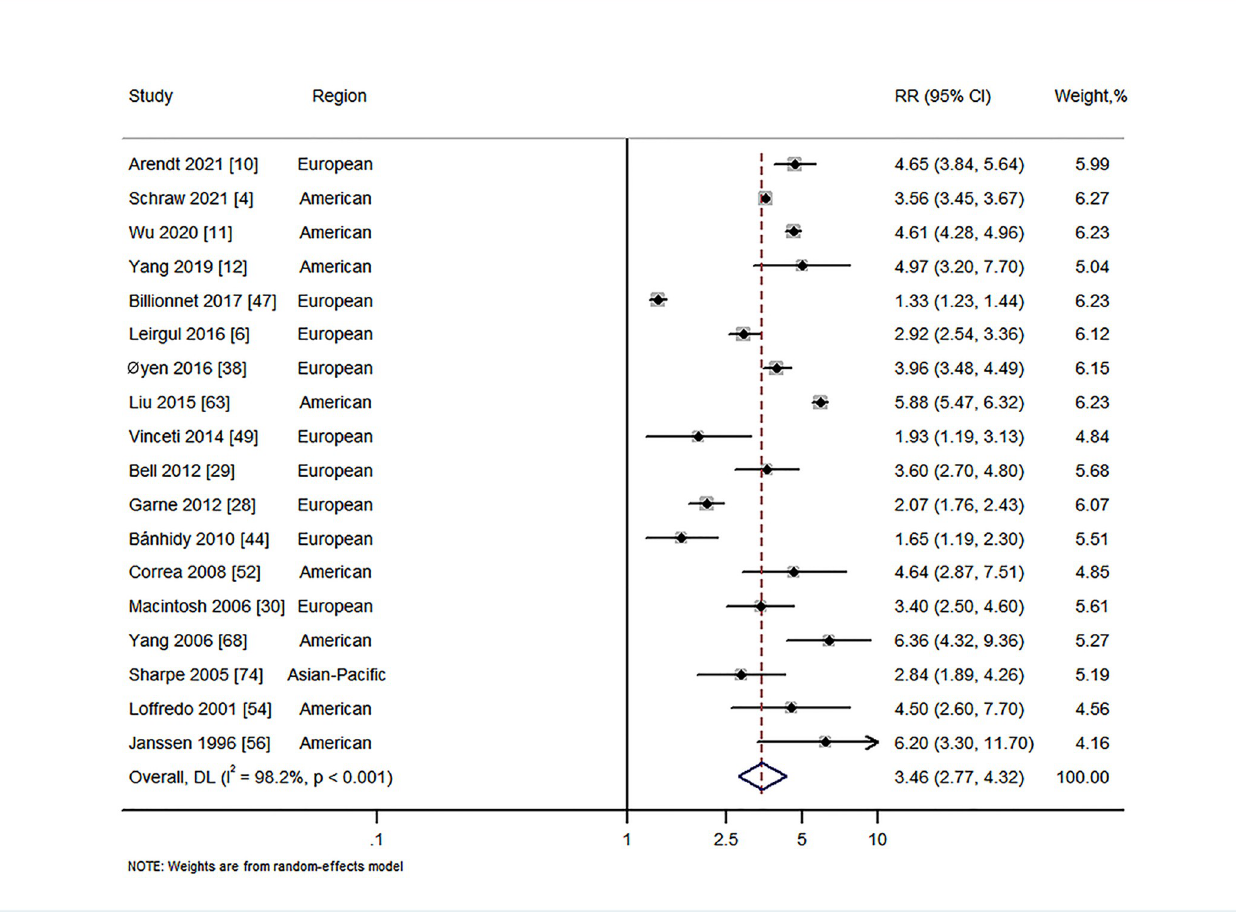
Fig 4. Forest plot of the RRs in population-based studies formaternal pre-gestational diabetes and the risk of congenital heart defects (RR = 3.46, 95% CI 2.77 to 4.32, I 2 = 98.2%, P < 0.001). Analytical weights are from random effects meta-analysis. Grey boxes represent study estimates; their size is proportional to the respective analytical weight. Lines through the boxes represent the 95% CIs around the study estimates. The diamond represents the mean estimate and its 95% CI. The vertical red dashed line indicates the mean estimate. CI, confidence interval; DL, DerSimonian and Laird random effects model; RR, relative